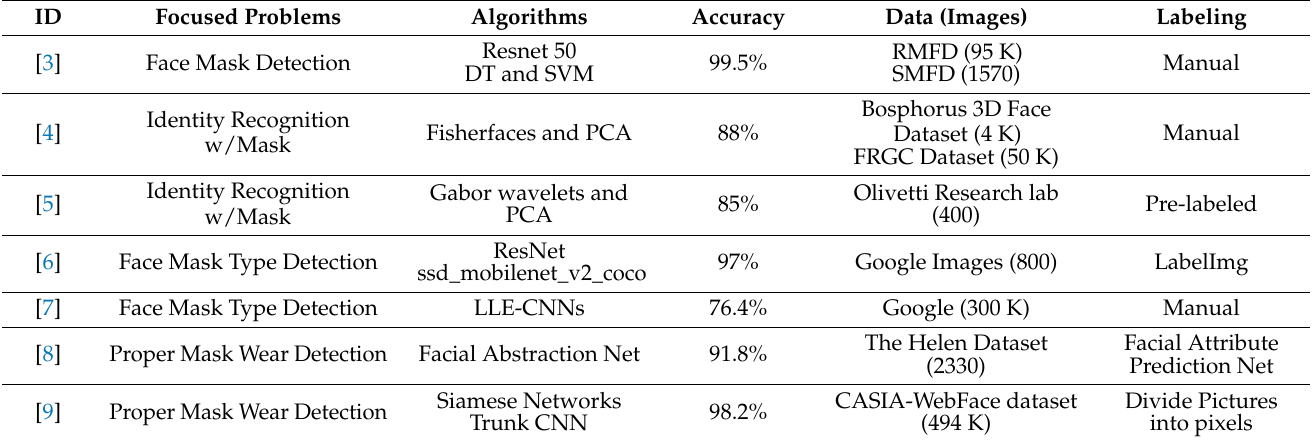
Table 1. Literature